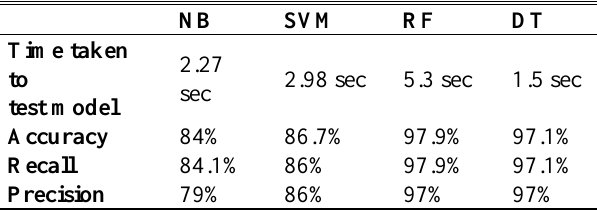
Table 8. Test Results of 18 attributes.